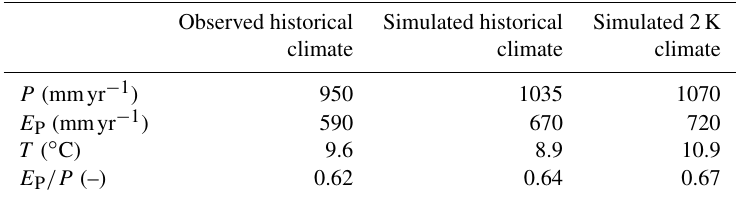
Table 1. Mean annual precipitation P , potential evaporation E P , temperature T and aridity index E P /P for the observed historical E-OBS data and the simulated historical and 2K climate data for the Meuse basin upstream of